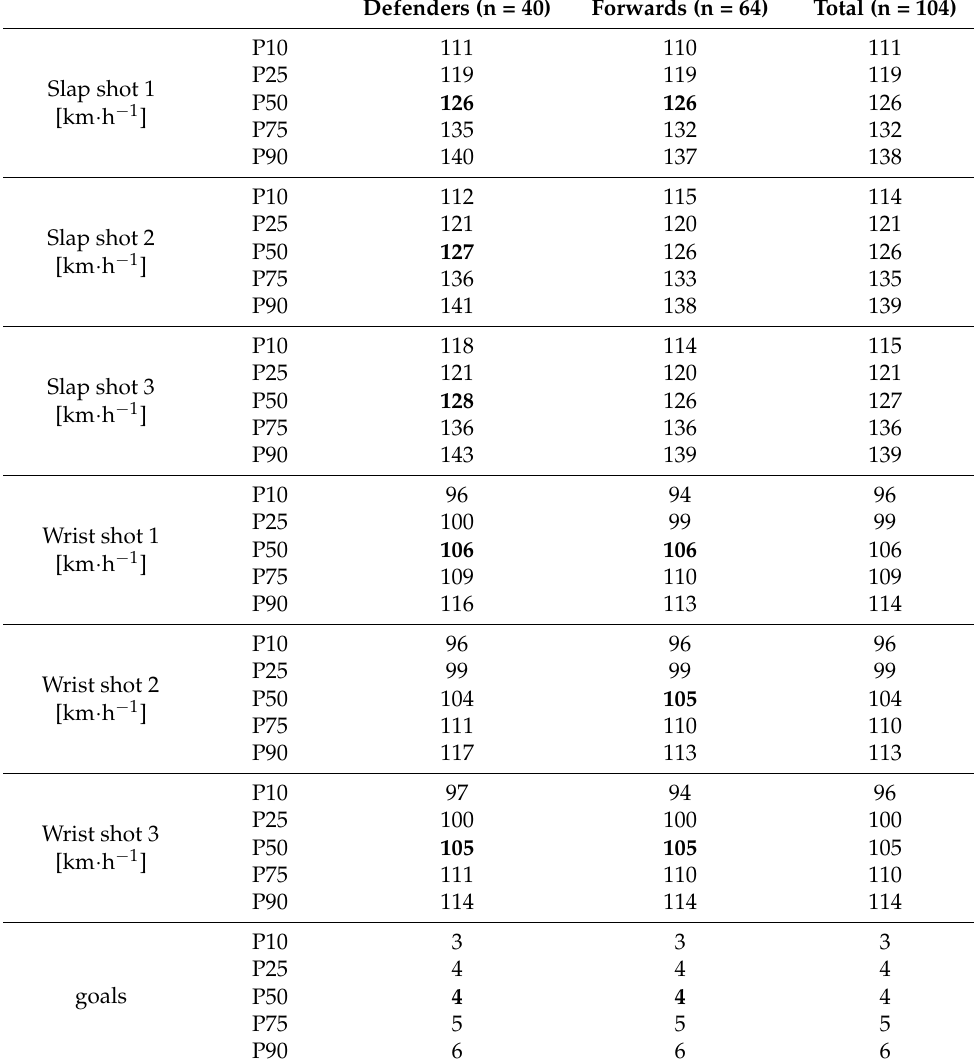
Table 4. Percentile data of shot performance before the test by playing position. Based on the 50th percentile, performance maxima marked in bold.